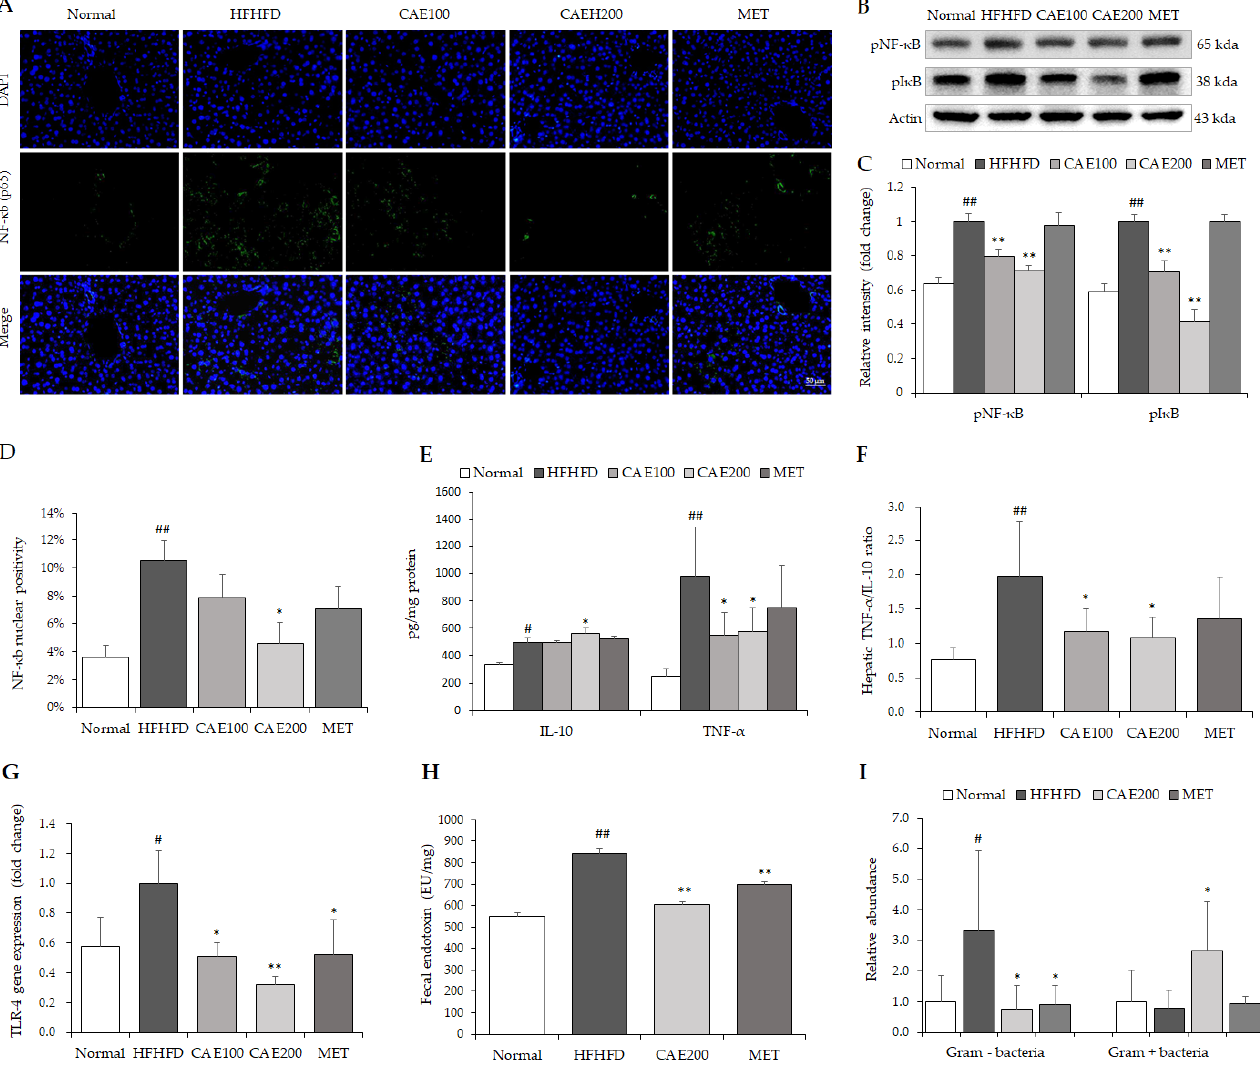
Figure 4. CAE attenuated hepatic inflammation-related factors. NF- К b phosphorylation in liver tissues was detected using immunofluorescent staining ( A ) (n = 6). The quantification of NF- κ b was performed using ImageJ software ( D ). The levels of hepatic phospho-NF- κ B and p65 phospho-I κ B were assessed via Western blot ( B ) (n = 6). The relative intensity was calculated using ImageJ software for comparison of fold change ( C ). Commercial ELISA kits determined serum anti-inflammatory (IL-10) and pro-inflammatory (TNF- α ) cytokines ( E ), and the hepatic TNF- α to IL-10 ratio was calculated to evaluate the liver inflammation status ( F ) (n = 6). The gene expression of TLR-4 in liver tissue was assessed using real-time PCR ( G ) (n = 6). The endotoxin in feces was measured using a Chromogenic Limulus Amebocyte Lysate (LAL) Endotoxin Assay Kit ( H ) (n = 6). Both the relative abundance of Gram-negative and Gram-positive ( I ) bacteria in feces were also detected using corresponding specific primers (n = 6). # p < 0.05 and ## p < 0.01, as compared to normal group; * p < 0.05 and ** p < 0.01, as compared to the HFHFD group.